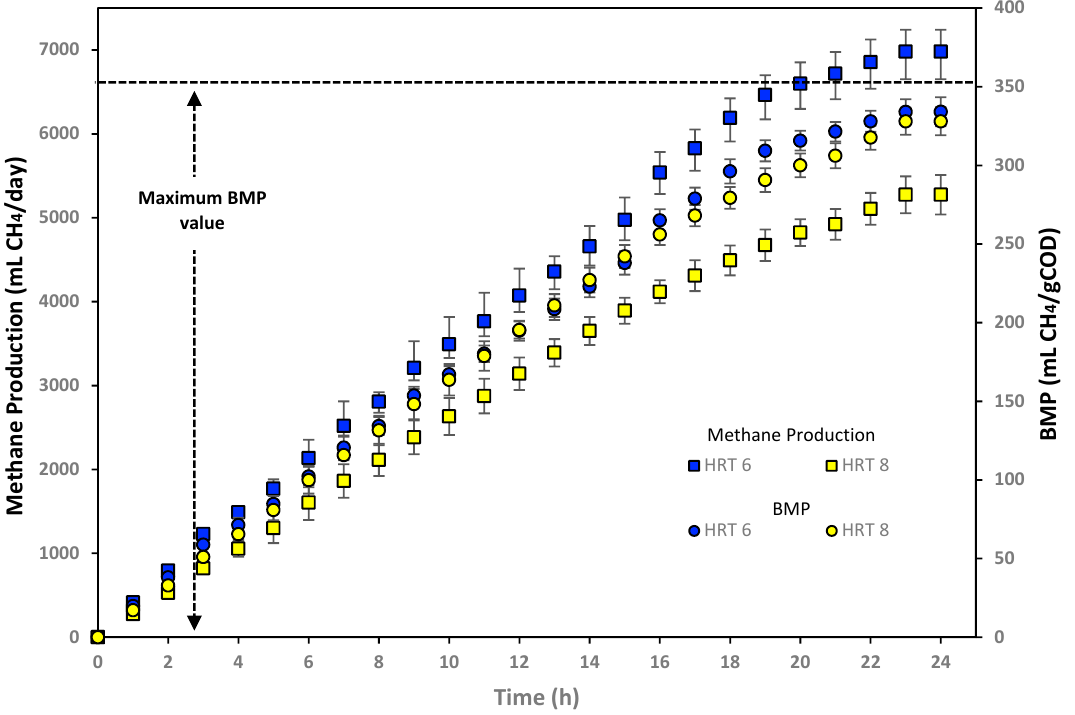
Figure 7. Methane production and BMP in the EGSB bioreactor at HRT of 6 and 8 days. The values shown are the media average with their standard deviations.